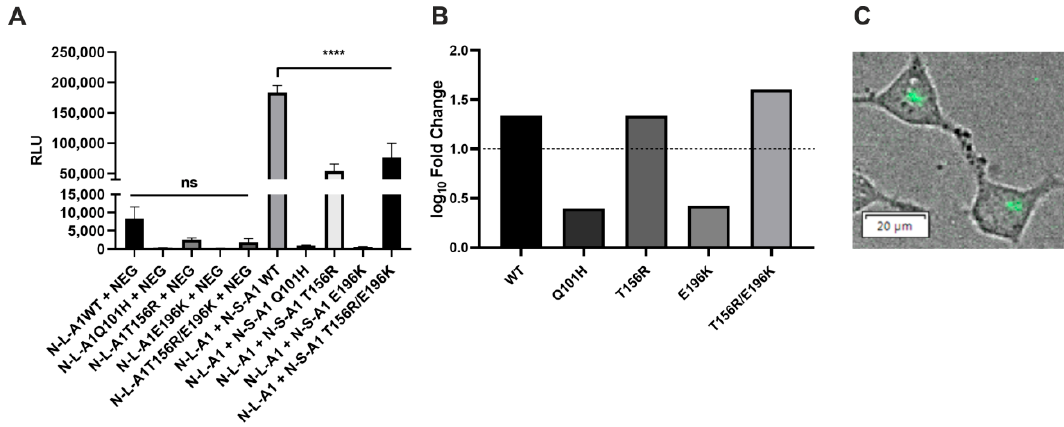
Figure 10. Analysis of dimerization of the CST variants using the NanoBiT approach. ( A ) RLU values obtained for the selected protein combinations and the corresponding negative controls. RLU, relative luminescence units; N-S-, protein tagged with SmBiT at the N-terminus; N-L-, protein tagged with LgBiT at the N-terminus; A1, SLC35A1; NEG, HaloTag tagged with SmBiT. Data were analyzed using one-way ANOVA with multiple comparisons and are presented as a mean ± standard deviation (SD) from three technical replicates. ns, not significant; p < 0.001 ****. Representative data from two biological replicates with similar tendencies are shown. ( B ) Decimal logarithms of the ratios calculated by dividing a mean luminescence obtained for the tested combination by a mean luminescence obtained for the corresponding control. The dashed line marks a level of a 10-fold increase (log10 fold change equal 1) of signal over control which sets a threshold of significance suggested by the manufacturer. ( C ) Bioluminescent imaging of the wild-type CST homodimerization in living HEK293T cells. The NanoLuc-derived luminescence (green) was merged with a brightfield image. Concentrated perinuclear localization of the signals strongly suggests that the CST monomers localize to and interact within the Golgi apparatus.